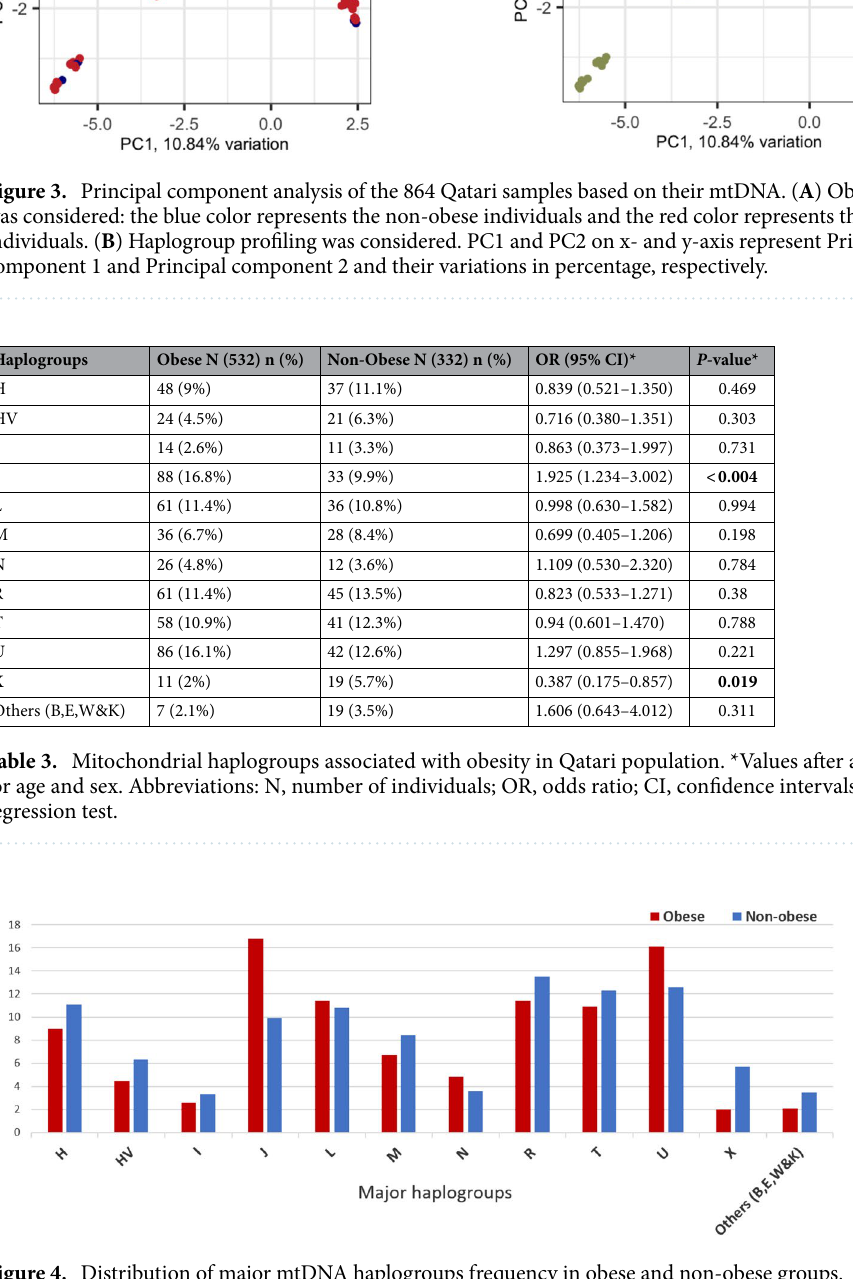
Figure 4. Distribution of major mtDNA haplogroups frequency in obese and non-obese